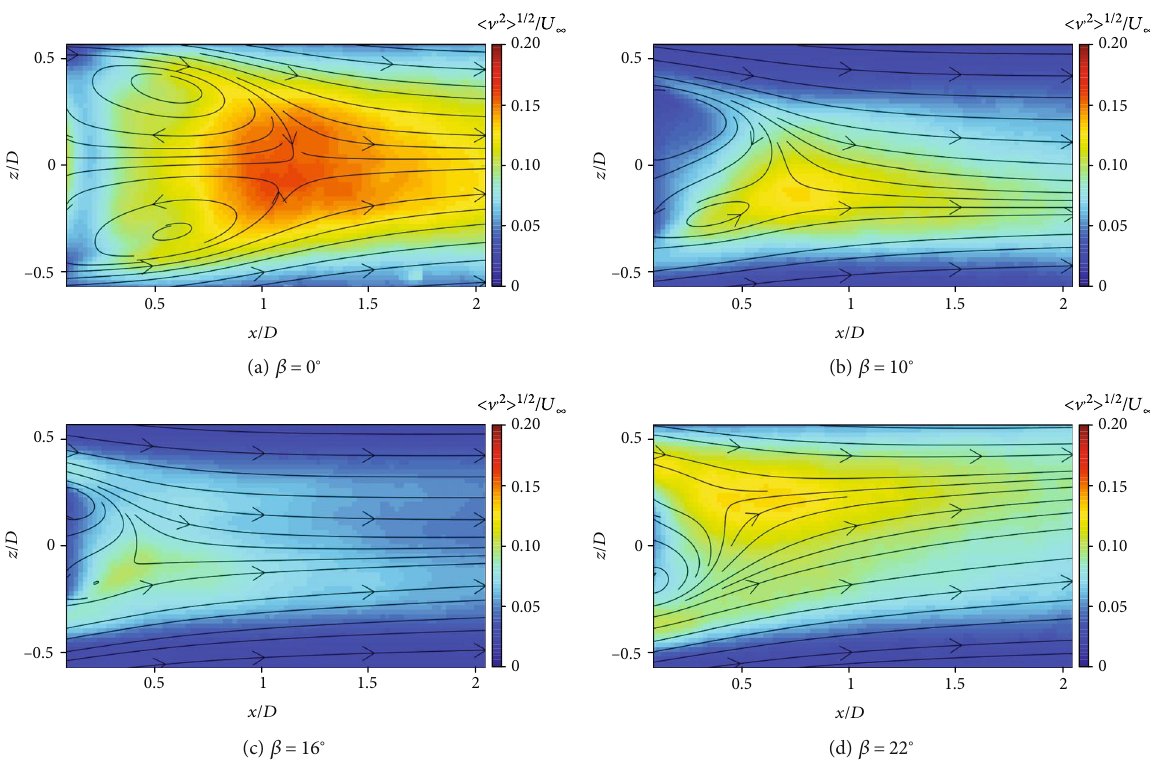
Figure 11: Crosswise turbulence level < v ,2 > 1/2 at di ff erent boattail angles (a) β = 0 ° , (b) β = 10 ° , (c) β = 16 ° , and (d) β = 22 °